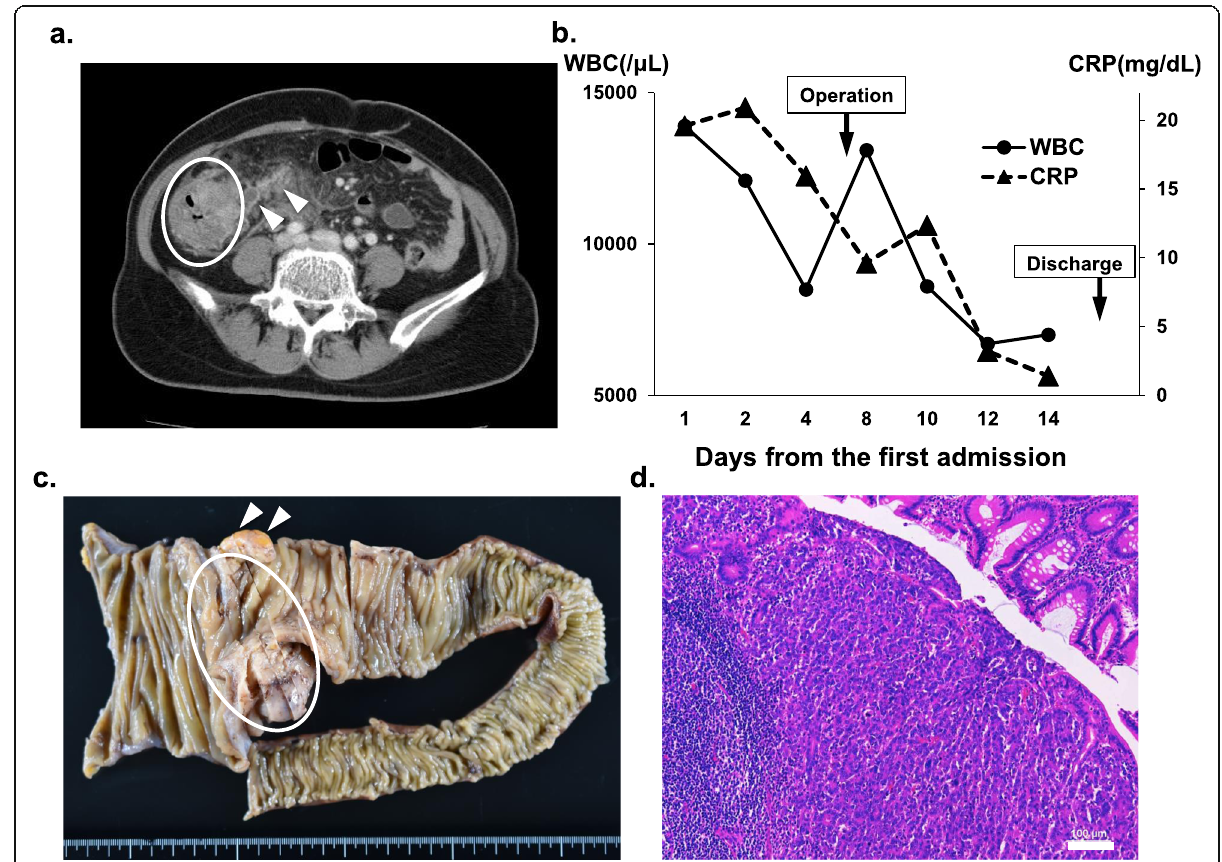
Fig. 3 a CT findings: CT revealed acute appendicitis (arrow heads) with abdominal abscess and irregular wall thickness of the cecum (circle). b The clinical course of this patient: she underwent interval operation at day 7 and left the hospital at postoperative day 9. c A macro-finding of the resected organ: the arrow heads indicate the appendix. The oval indicates the tumor lesion. d Pathological examination: pathological features revealed poorly differentiated